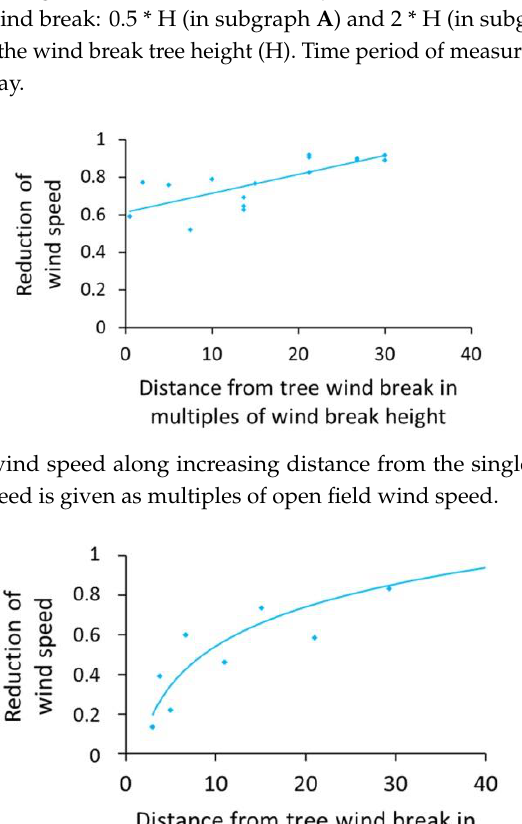
Figure 9. Reduction of wind speed along increasing distance from the multiple row tree wind break with understory vegetation. The reduction of wind speed is given as multiples of open field wind speed.